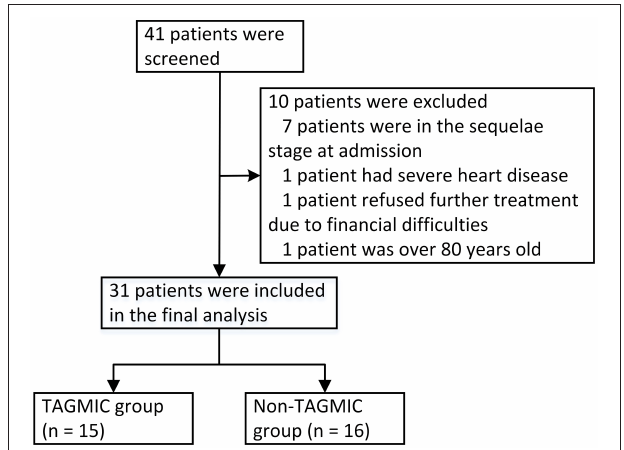
FIGURE 1 | Flow chart of patient inclusion, exclusion, and grouping. TAGMIC: ganciclovir, methylprednisolone, and immunoglobulin combination.